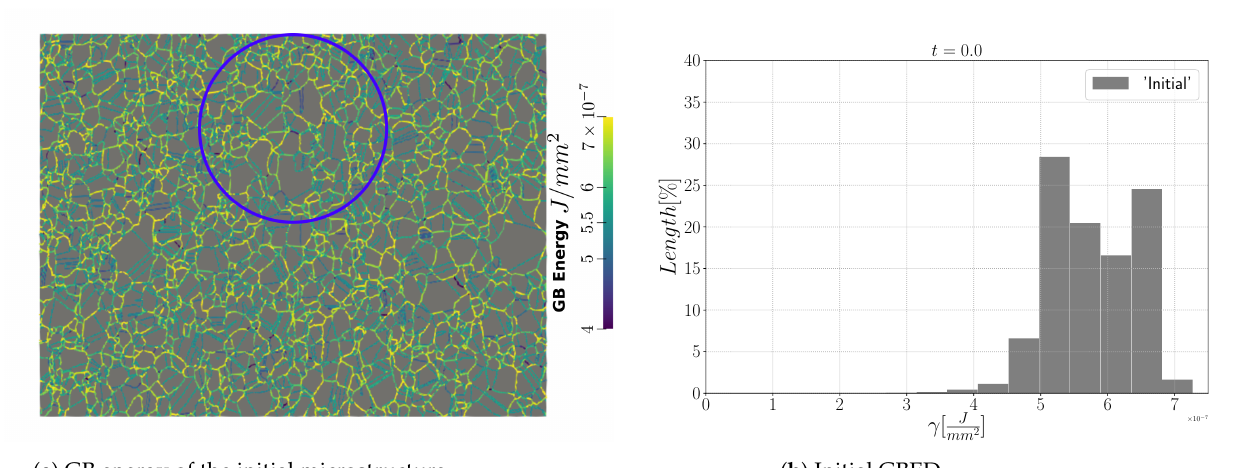
Figure 25. ( a ) GB energy field and ( b ) GBED of the initial immersed microstructure obtained using the GB5DOF code with the parameters (cid:101) RGB = 0.763 J mm − 2 and AlCu-parameter = 0. In ( a ), the · blue circle shows a zone of interest with a twin boundary composed of a coherent and incoherent part, similar to the one shown in [22].